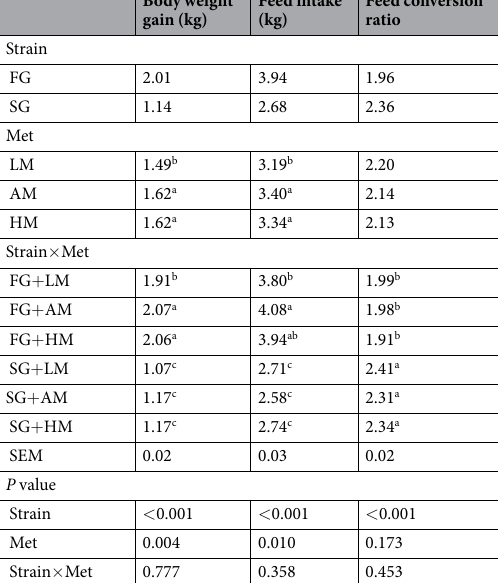
Table 1. Effects of dietary methionine on growth performance of broilers from 1 to 42 d of age. Results are presented as means and pooled SEM (n = 6). Mean values within a column with unlike superscript letters were significantly different ( P <